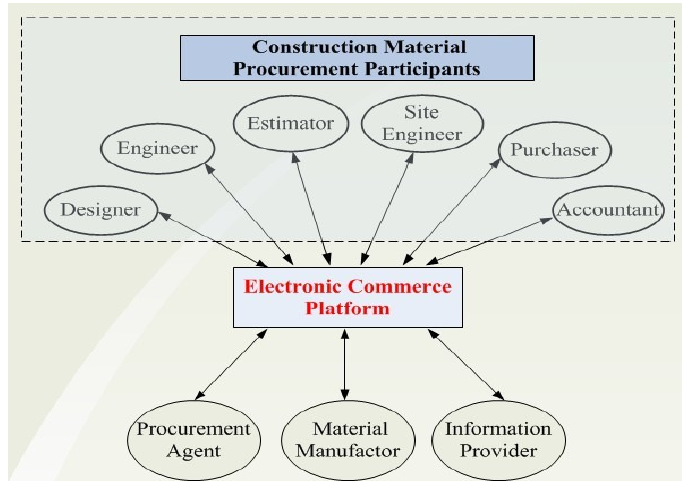
Fig. 1. E-commerce platform for construction material procurement participants Table 1. Construction tendering, biding and procurement related websites General